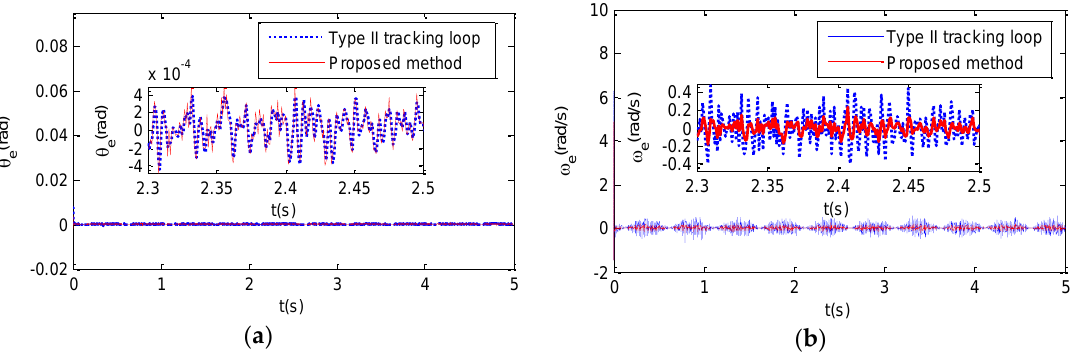
Figure 9. Estimation errors of the two demodulation methods in Case 1. ( a ) Rotor position estimation error; ( b ) rotor velocity estimation error.